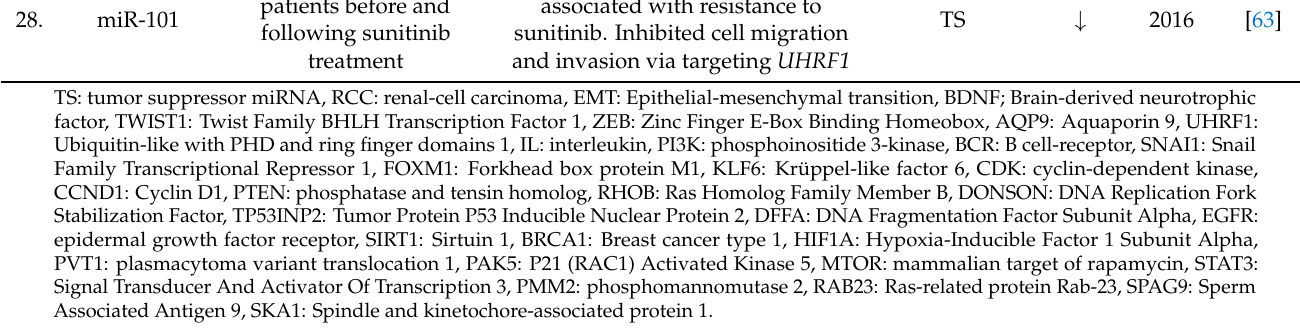
Krüppel-like factor 6, CDK: cyclin-dependent kinase, CCND1: Cyclin D1, PTEN: phosphatase and tensin homolog, RHOB: